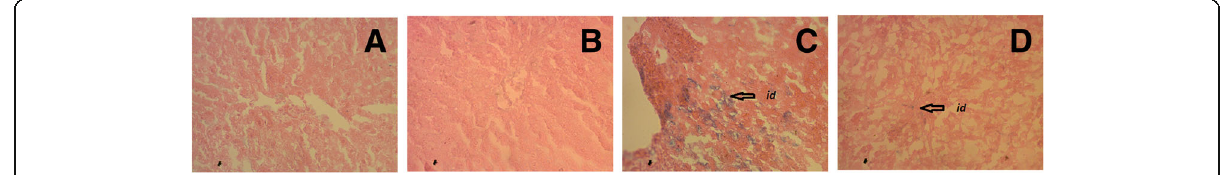
Fig. 6 Effect of Syzygium cumini seed powder supplementation on hepatic iron deposition in high fat diet fed obese rats. a Control; b Control + Syzygium cumini seed; c HCHF; d HCHF+ Syzygium cumini seed. Magnification 40